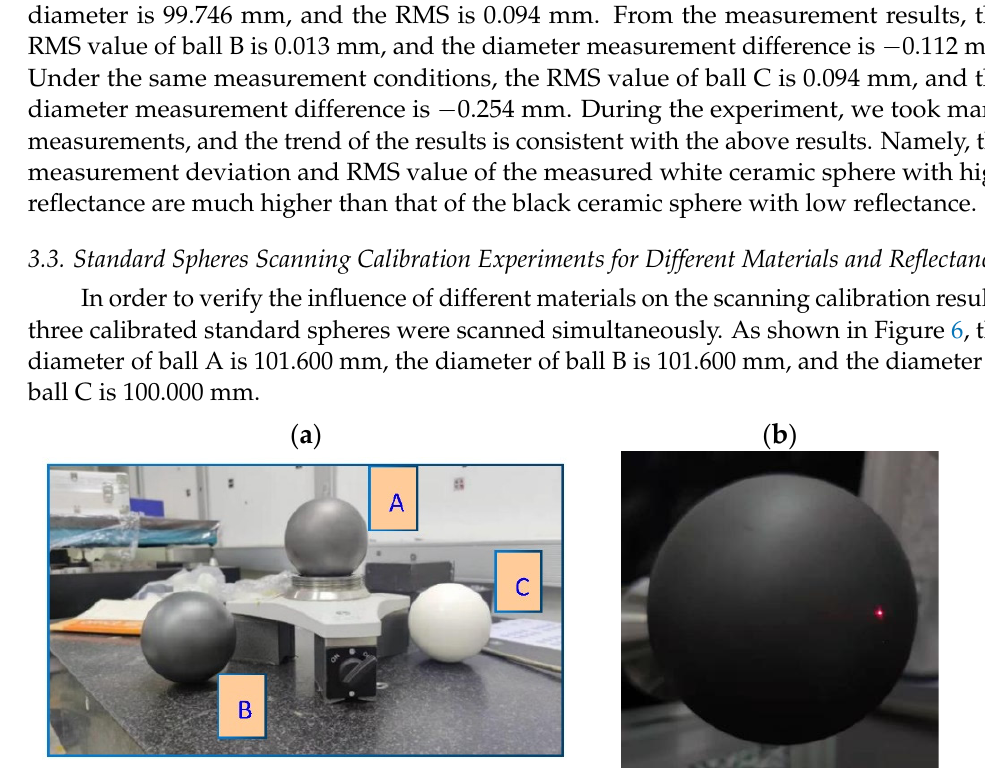
Figure 6. Scanning measurement comparison based on different reflectance: ( a ) The standard spheres made by three different materials with different reflectance, and ( b ) scanning light spot on black ceramic surface.